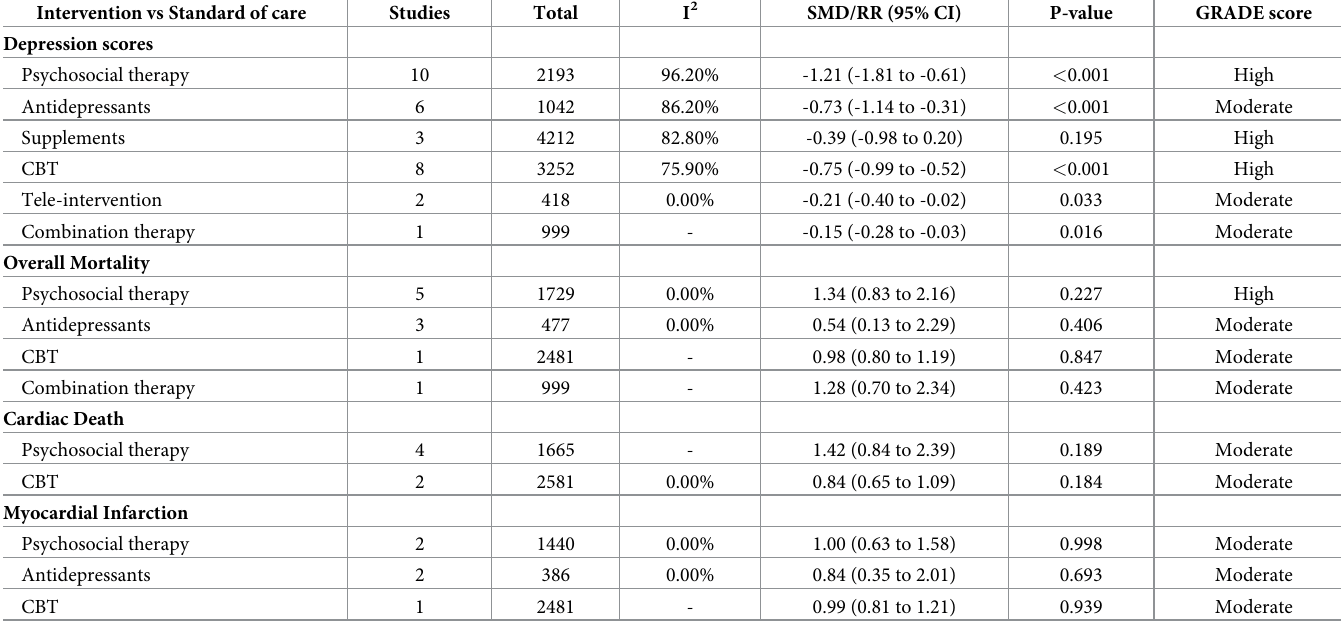
Table 1. Summary of bivariate